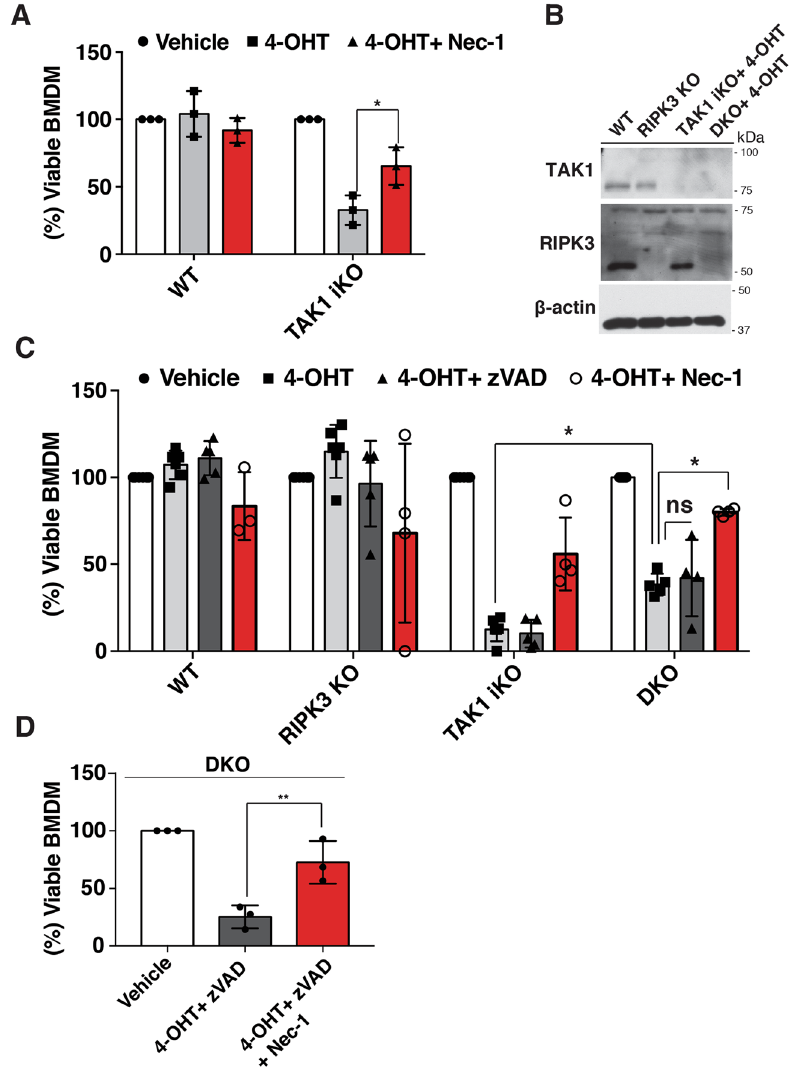
Figure 2. Tak1 -deficient macrophage die through a caspase- and RIPK3- independent death pathway ( A ) WT and TAK1 iKO BMDMs cells were treated with 0.3 μ M 4-OHT together with vehicle or Nec-1 for 7 days. Cell viability was determined by crystal violet assay. Data are the result of 3 independent experiments and show mean percentages + / − SD. * p-value < 0.05; two-way ANOVA. ( B ) Whole cell extracts were harvested from WT, TAK1 iKO and RIPK3 KO and DKO BMDMs treated with 0.3 µ M 4-OHT for 4 days. ( C ) WT, Ripk3 − / − (RIPK3 KO), TAK1 iKO , and Ripk3 − / − TAK1 iKO (DKO) BMDMs were treated with 0.3 μ M 4-OHT or vehicle (ethanol) + / − 20 µ M zVAD or 50 µ M Nec-1. Data are the result of at least 3 independent experiments and show mean percentages + / − SD. ns, not significant; * p-value < 0.05; two-way ANOVA. ( D ) RIPK3 KO BMDMs were treated with 0.3 μ M 4-OHT together with 20 µ M zVAD and 50 µ M Nec-1. Data are the result of 3 independent experiments and show mean percentages + / − SD. ns, not significant; ** p-value < 0.01; one-way